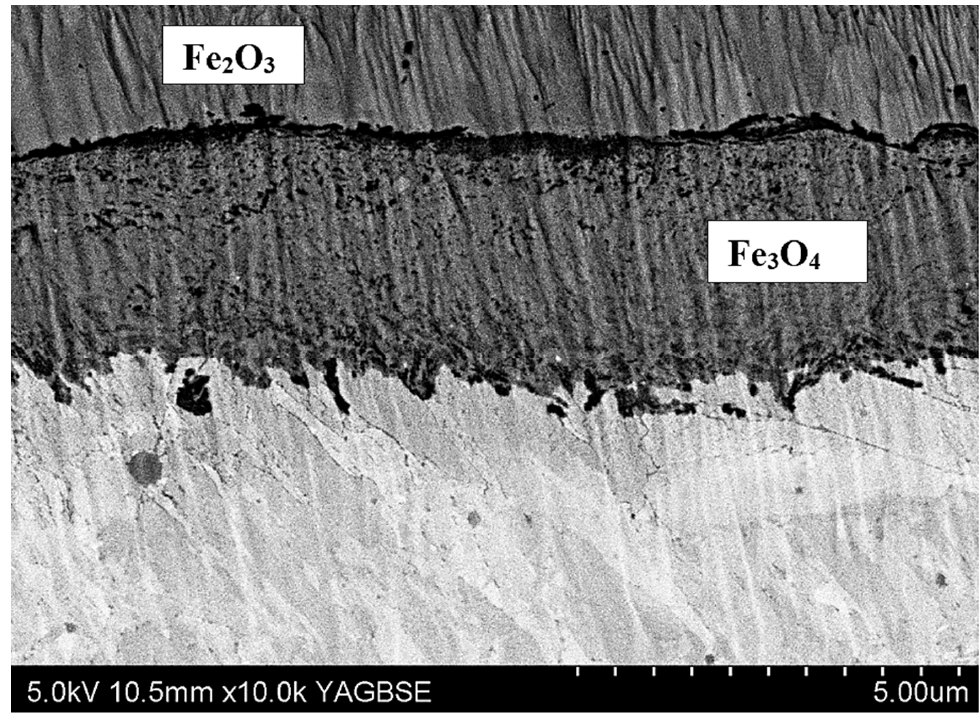
Figure 9. Oxide layer growing into the substrate, v7, two sections with Fe 2 O 3 and Fe 3 O 4 content are identified (total annealing time 22 h) magnification 10,000× (SEM).